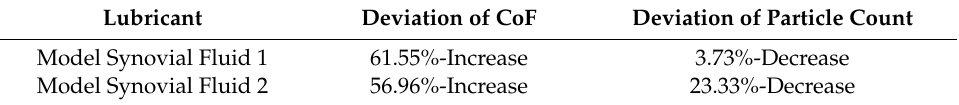
Figure 16. CoF trend: Model Synovial Fluid 1.